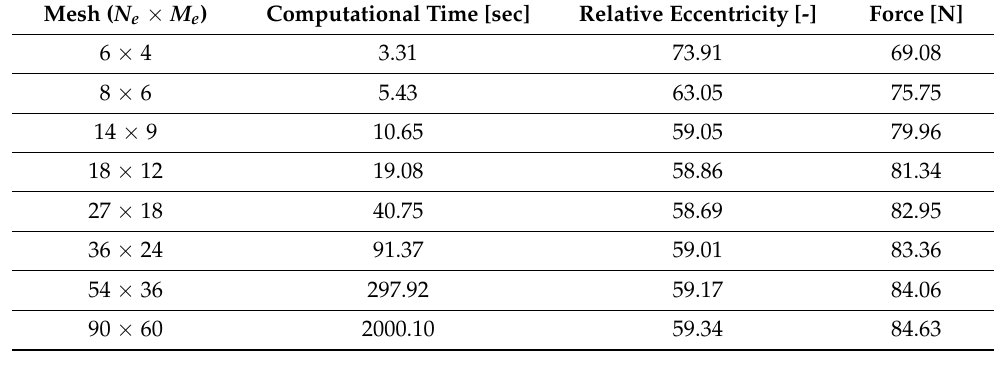
Table 5. The unbalance response simulation results for Model II for different number of mesh elements. A MATLAB tic-toc command was used to find the computational time.